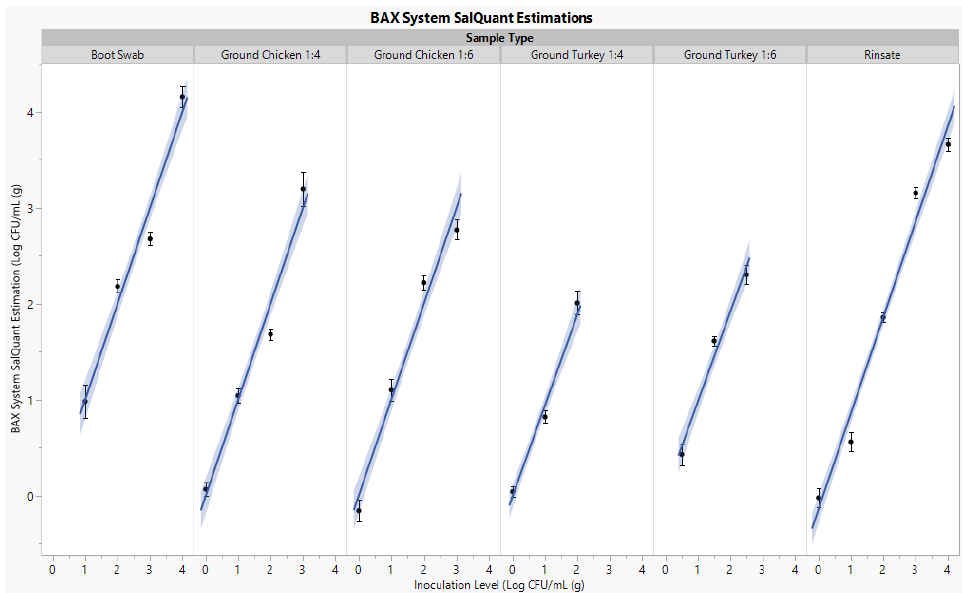
Figure 2. BAX ® System SalQuant ® Linear-Fit Curve Estimations of Various Poultry Matrices by Inoculation Level .